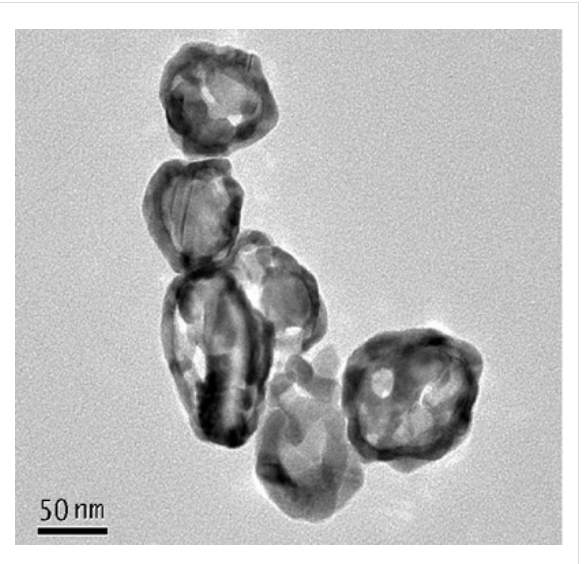
Figure 3: TEM image of Ag–Au NCs prepared by galvanic replace- ment reactions for 2 h and removed from the substrate